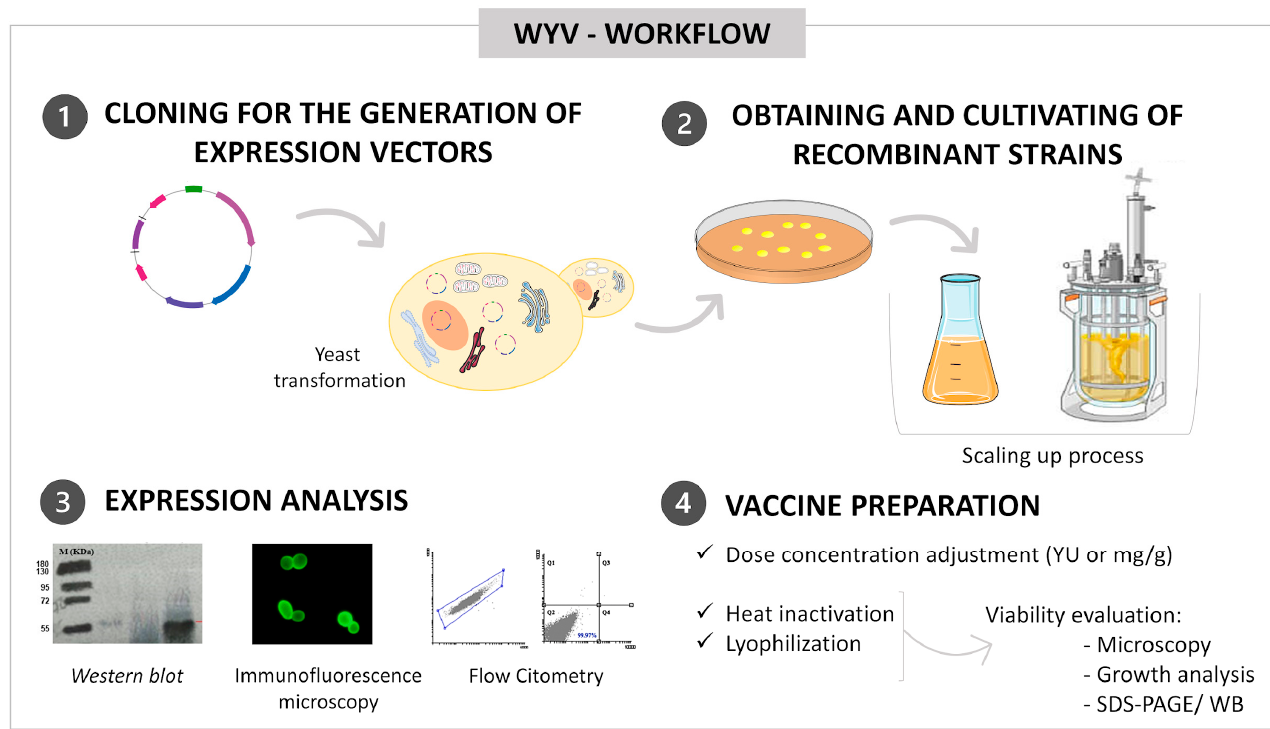
Figure 2. Steps for whole yeast vaccine development that must be performed before immunological assays.